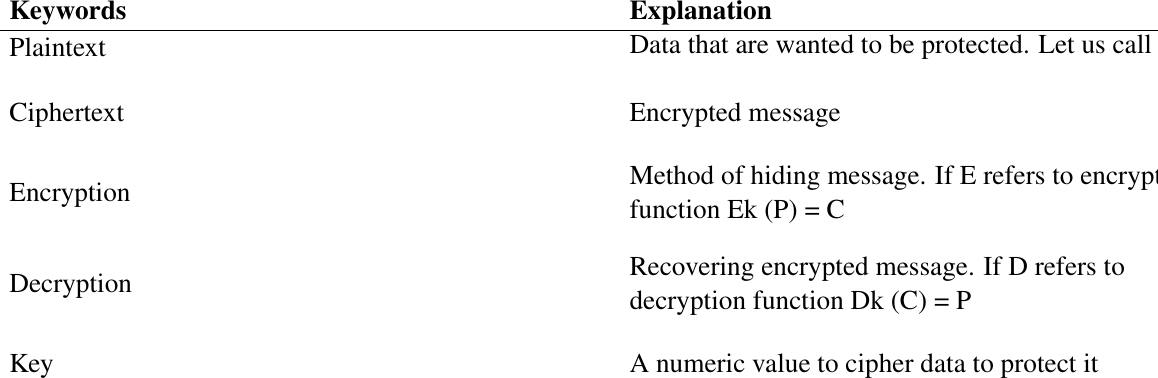
Table 1 Main terms in